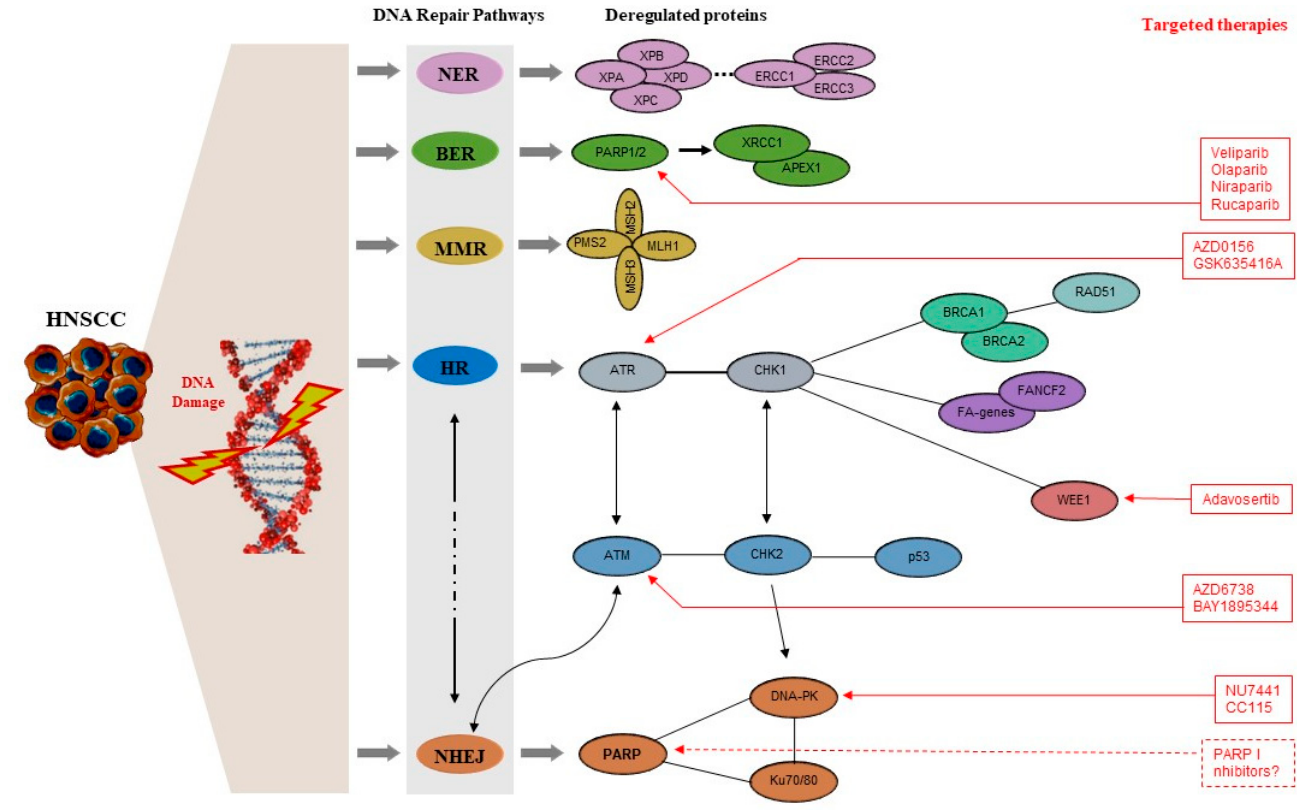
Figure 1. Schematic representation of the main DNA repair pathways, the proteins involved in each pathway that are deregulated in HNCs, and the inhibitors that are being investigated as targeted therapeutics. The clarification of the complex interactions between DDR genes with altered expression in HNC can reveal potential biomarkers for predicting clinical outcome and for guiding therapy selection. The investigation of the complex interplay between the different DNA repair mechanisms, and how these are affected by the altered expression of key proteins in HNC, can significantly contribute to the development of new inhibitors for targeted therapy. APEX1: Apurinic/Apyrimidinic Endodeoxyribonuclease 1; ATM: Ataxia Telangiectasia Mutated; ATR: Ataxia Telangiectasia and Rad3-related; BER: Base Excision Repair; BRCA1: Breast Cancer gene 1; BRCA2: Breast Cancer gene 2; CDKi: Cyclin-Dependent Kinase inhibitor; CHK1: Checkpoint kinase 1; CHK2: Checkpoint kinase 2; DDR: DNA damage response; DNA-PKi: DNA-dependent Protein Kinase inhibitor; DSBs: dou- ble-strand breaks; ERCC1: Excision Repair Cross-Complementing Rodent Repair Deficiency, Com- plementation Group 1; ERCC2: excision repair cross-complementing rodent repair deficiency Gene Anemia genes; FANCD2: Fanconi Anemia Complementation Group D2; HNC: head and neck can- cer; HNSCC: Head and Neck Squamous Cell Carcinoma; HR: Homologous Recombination; MLH1: MutL protein homolog 1; MMR: Mismatch Repair; MSH2: MutS homolog 2; MSH3: MutS Homolog 3; NER: Nucleotide Excision Repair; NHEJ: Nonhomologous End Joining; PARP1/2: Poly(ADP-Ri- bose) Polymerase 1/2; 2PARPi: Poly (ADP-ribose) Polymerase inhibitor; PMS2: Postmeiotic Segre- gation Increased 2; SSBs: single-strand breaks; XPA: Xeroderma pigmentosum complementation group A; XPB: xeroderma pigmentosum, complementation group B; XPC: Xeroderma pigmento- sum, complementation group C; XPD: Xeroderma Pigmentosum, complementation Group D; XRCC1: X-ray Repair Cross Complementing protein 1. 4.5. Genes That Have Been Functionally Related to HPV(+) HNSCCs HPV oncogenes E6 and E7 are responsible for tumor initiation and immortalization, and are known to deregulate the onco-suppressor gene TP53 and retinoblastoma protein (pRb), thereby leading to deregulation of the cell cycle and inhibition of apoptosis [184– 186]. Relevant information from the TCGA database indicates that a great proportion of